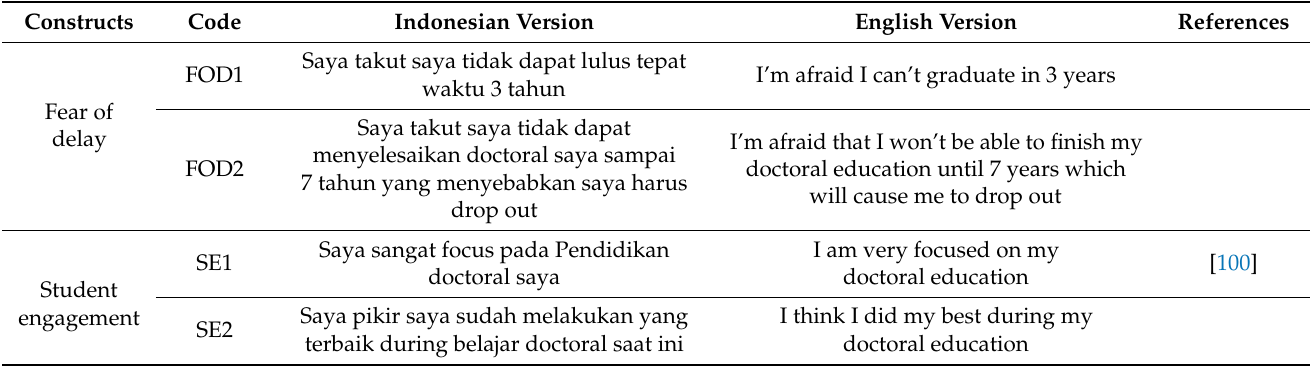
Table A1. Measurement items in the